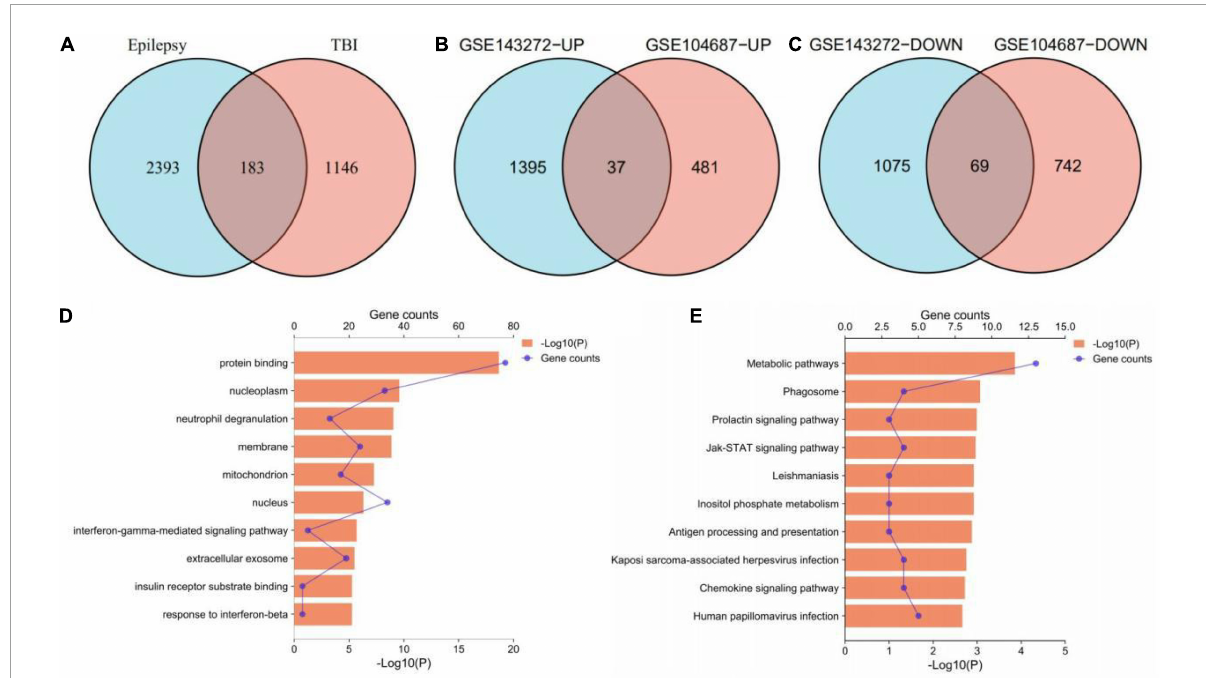
FIGURE2 Identification and functional enrichment of cross-talk genes. (A) 183 common DEGs. (B) 37 upregulated genes. (C) 69 downregulated genes. (D) GO terms of cross-talk genes (top 10 terms were listed). (E) KEGG terms of cross-talk genes (top 10 terms were listed). DEGs, differentially expressed genes; GO, gene ontology; KEGG, Kyoto Encyclopedia of Genes and